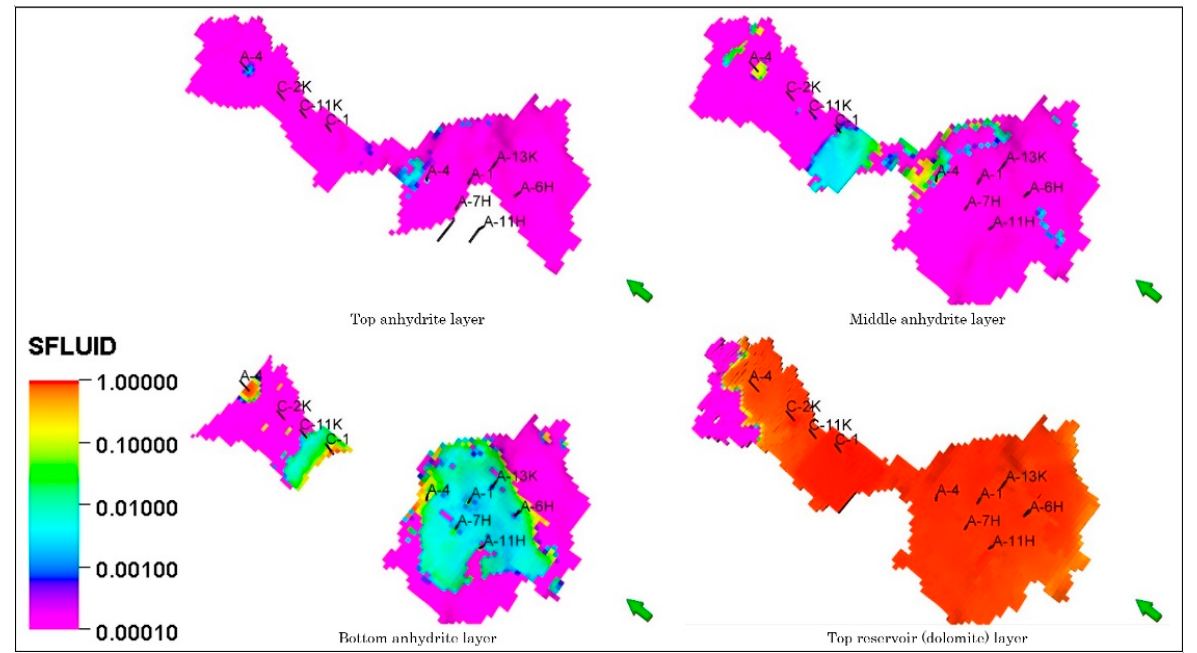
Figure 28. Reservoir fluid distribution at reservoir top and anhydrite caprock layers 94 years after injection. Scenario P520.